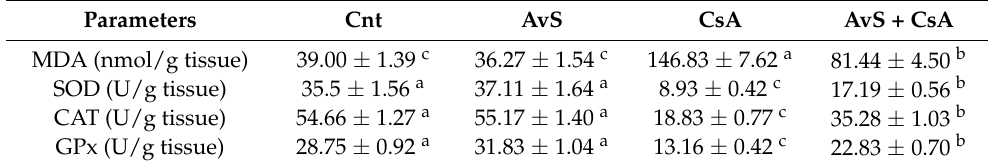
Table 4. Effects of AvS on hepatic oxidant and antioxidant status in rats with CsA-induced hepatotoxicity. Parameters